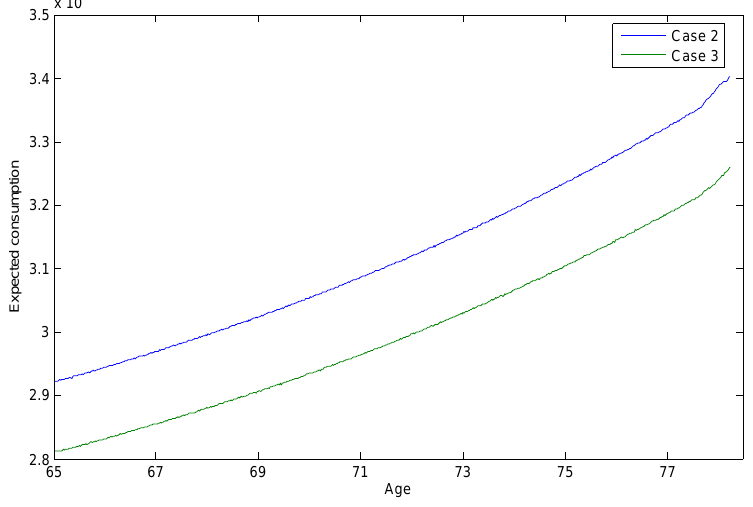
Figure 2. Expected consumption, truncated at optimal stopping times, for case 2 and case 3 agents commencing at age 65 in the healthy state with total wealth of 10 Y . The figure captures the expected consumption paths for agents with bequest motives. These agents, in contrast to case 1, have access to perfect insurance